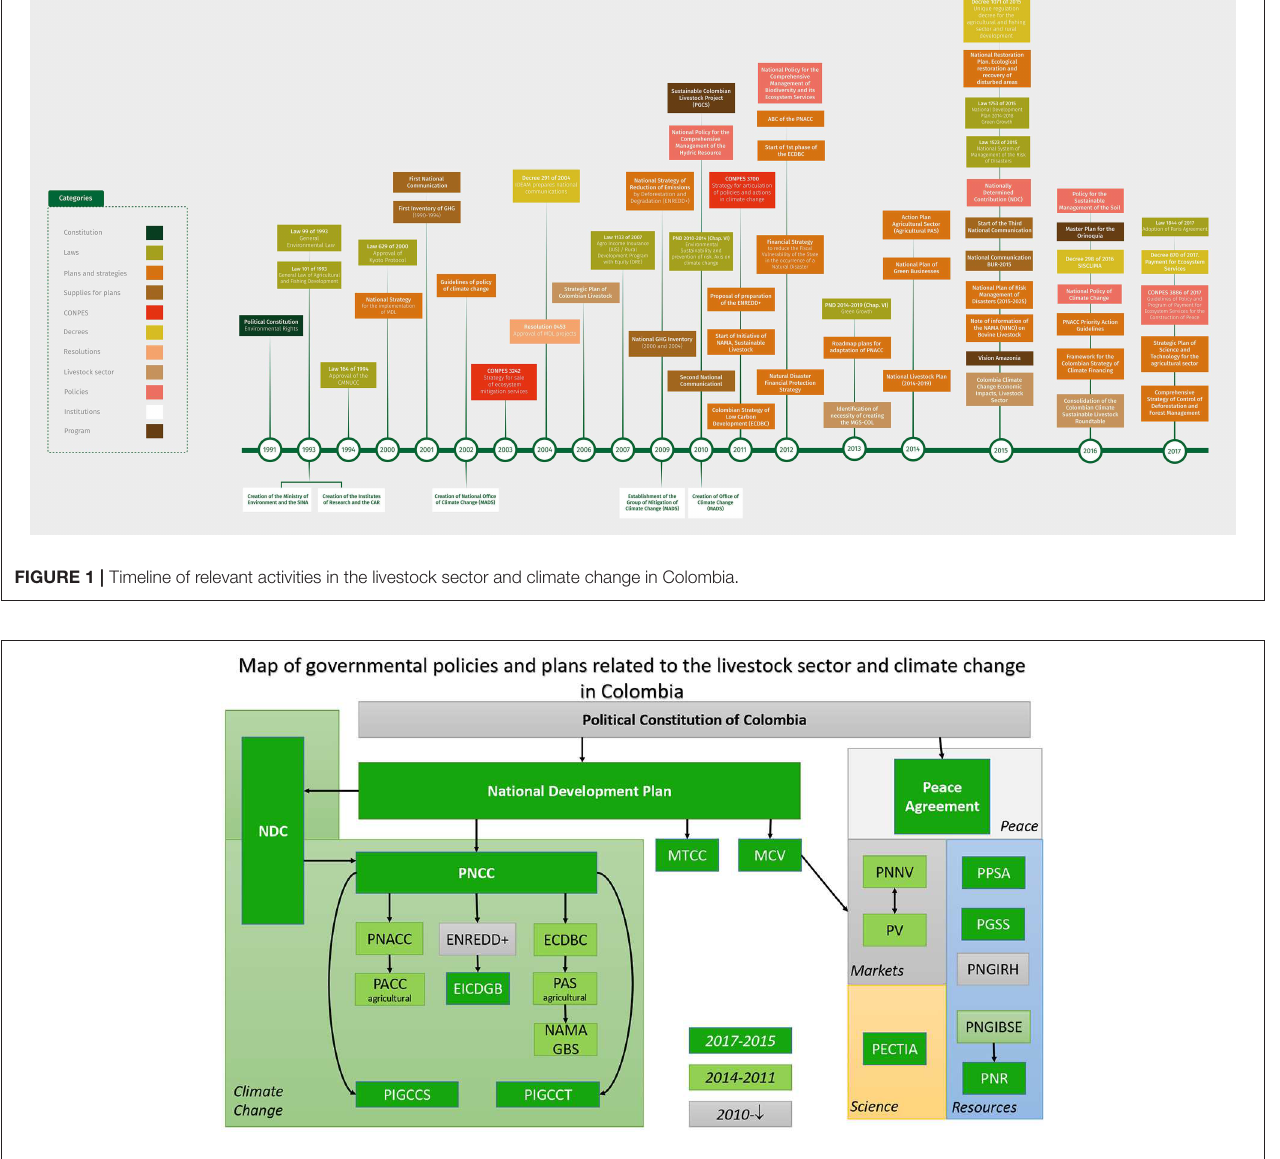
FIGURE 2 | Map of governmental policies and plans related to the livestock sector and climate change in Colombia. NDC, Determined Contribution at National Level; PNCC, National Policy of Climate Change; PNACC, National Plan of Adaptation to Climate Change; PACC A., Plan of Adaptation to Climate Change of the Agricultural sector; ENREDD + , National Strategy for Reduction of Emissions by Deforestation and Forest Degradation; EICDGB, Comprehensive Strategy of Control of Deforestation and Management of the Forests; ECDBC, Colombian Strategy of Low Carbon Development; PAS A., Action Plan of the Agricultural Sector; NAMA GBS, Nationally Appropriate Mitigation Action for Sustainable Bovine Livestock sector; PIGCCS, Comprehensive Sectorial Plans for Management of Climate Change; PIGCCT, Comprehensive Territorial Plans for Management of Climate Change; MTCC, Mission for the Transformation of the Colombian Countryside; MCV, Mission of Green Growth; PNNV, National Plan of Green Businesses; PV, Green Protocol; PECTIA, Strategic Plan of Science, Technology, and Innovation of the Colombian Agricultural Sector; PPSA, Policy of Payment for Ecosystem Services (PES) (Decree 870 of 2017); PGSS, Policy for the Sustainable Management of the Soil; PNGIRH, National Policy for the Comprehensive Management of the Hydric Resource; PNGIBSE, National Policy for the Comprehensive Management of the Biodiversity and its Ecosystem Services; PNR, National Restoration Plan.